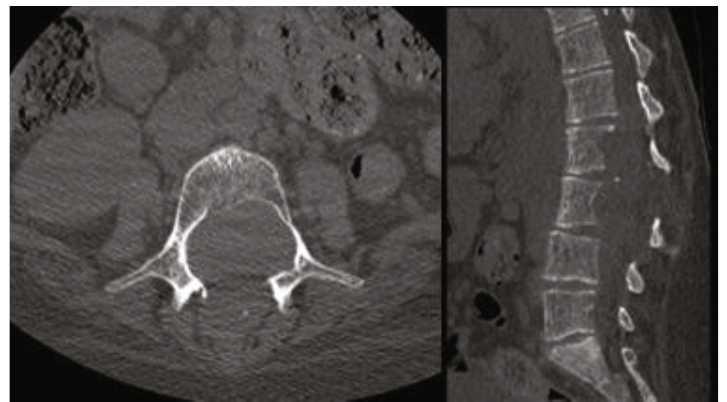
Figure 3: A lumbar spine CT scan: axial and sagittal views.